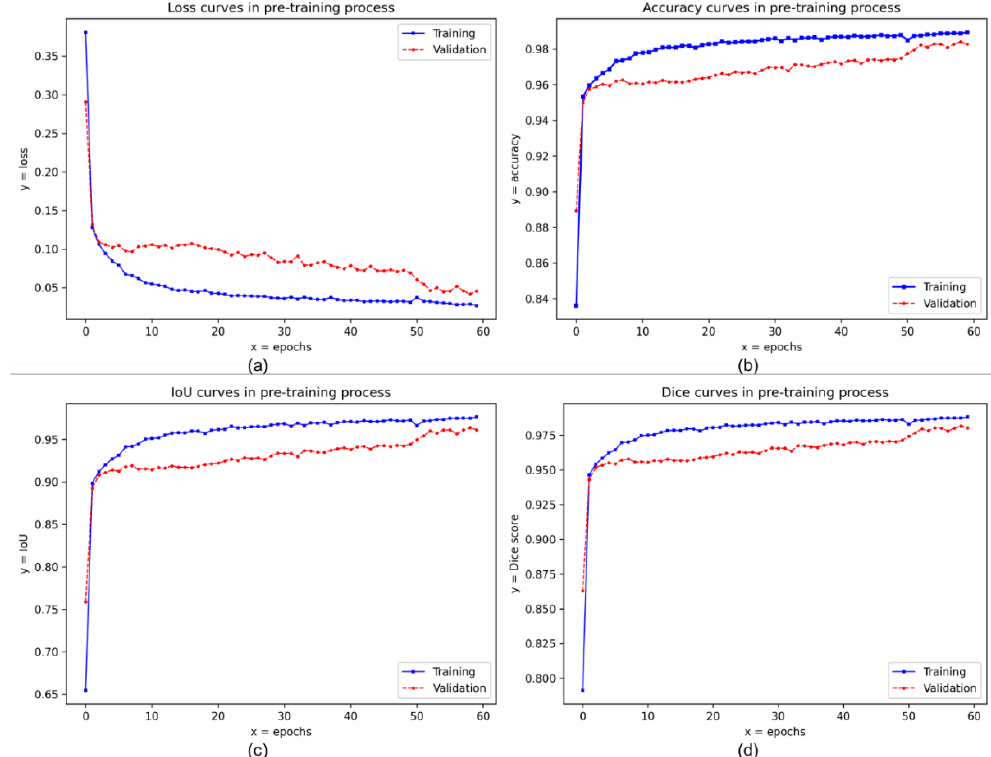
Figure A5. The loss (binary cross-entropy), accuracy, IoU, and Dice score records of the re-implemented U-Net in the pre- training process in training and validation set (the Skyfinder dataset). ( a – d ) refer to the loss (binary cross-entropy), accu- racy, IoU, and Dice score, respectively.